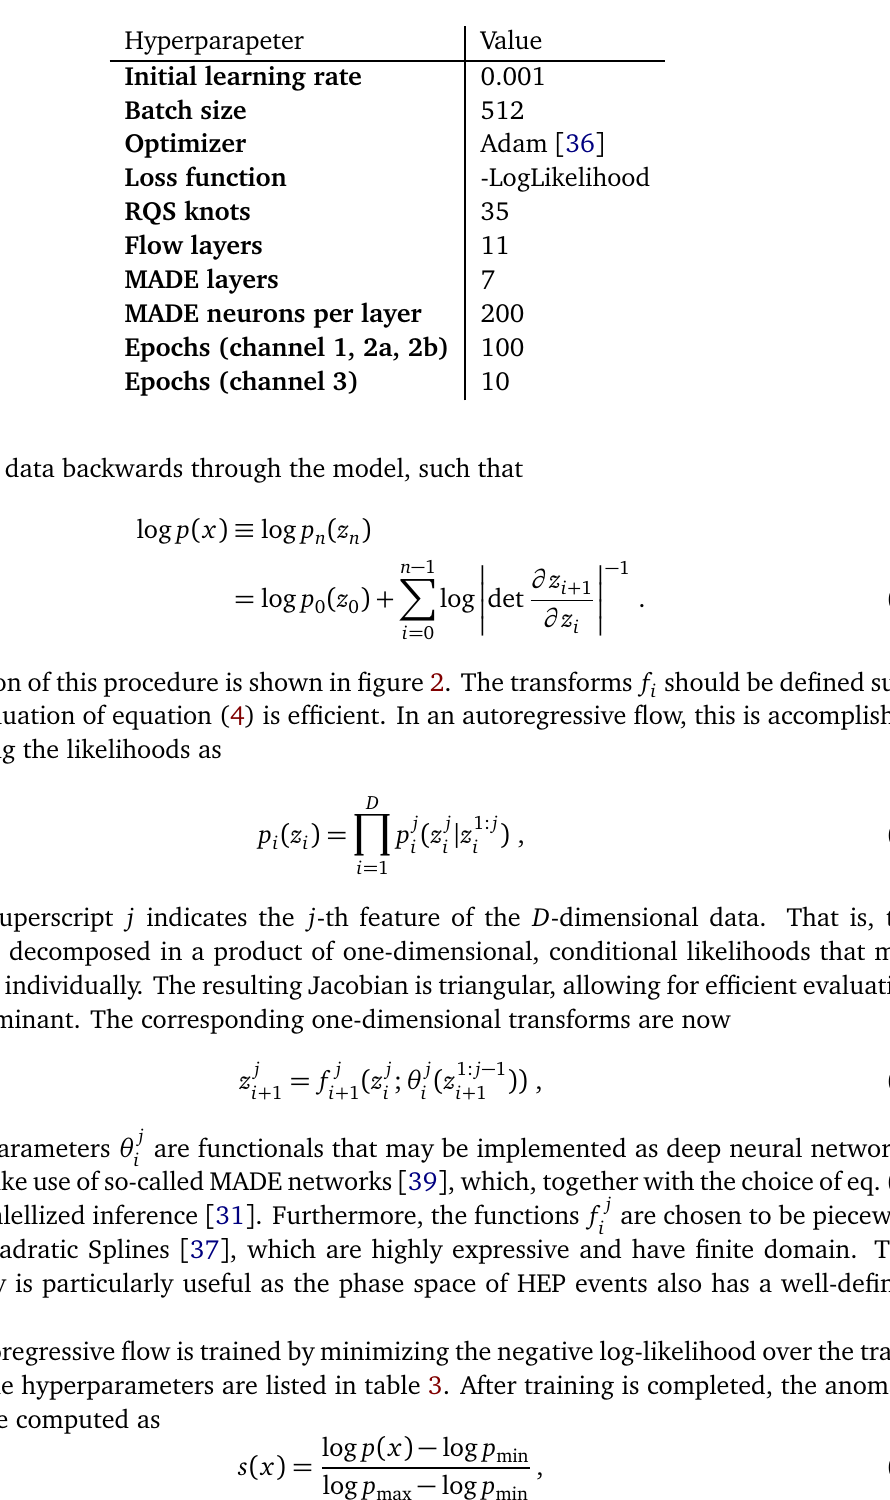
Table 3: Parameter combinations used for the training of the flow